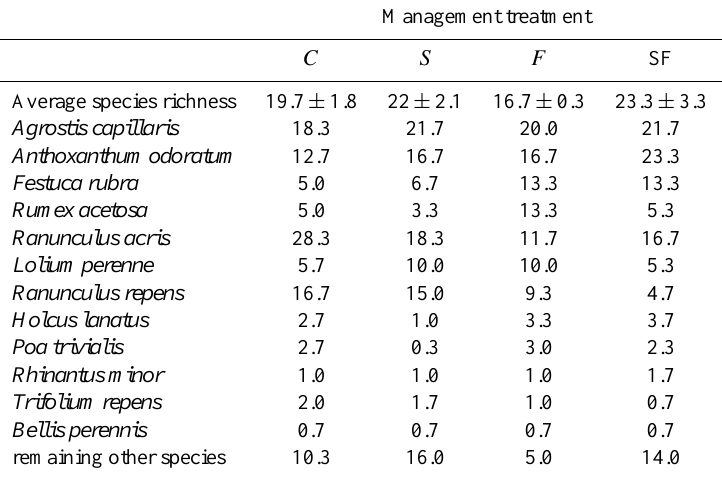
Table 1. Plant species richness (per 4m 2 ) and abundance cover (%) of vascular plant species in relation to restoration management treat- ments. Management treatments are: C =no seed, no fertiliser; S =with seed, no fertiliser; F =no seed, with fertiliser; SF=with seed, with fertiliser. Values are means ± 1SE ( N = 3), no number indicates absence of the species, SE of species abundance cover not included because many species occurred in only one